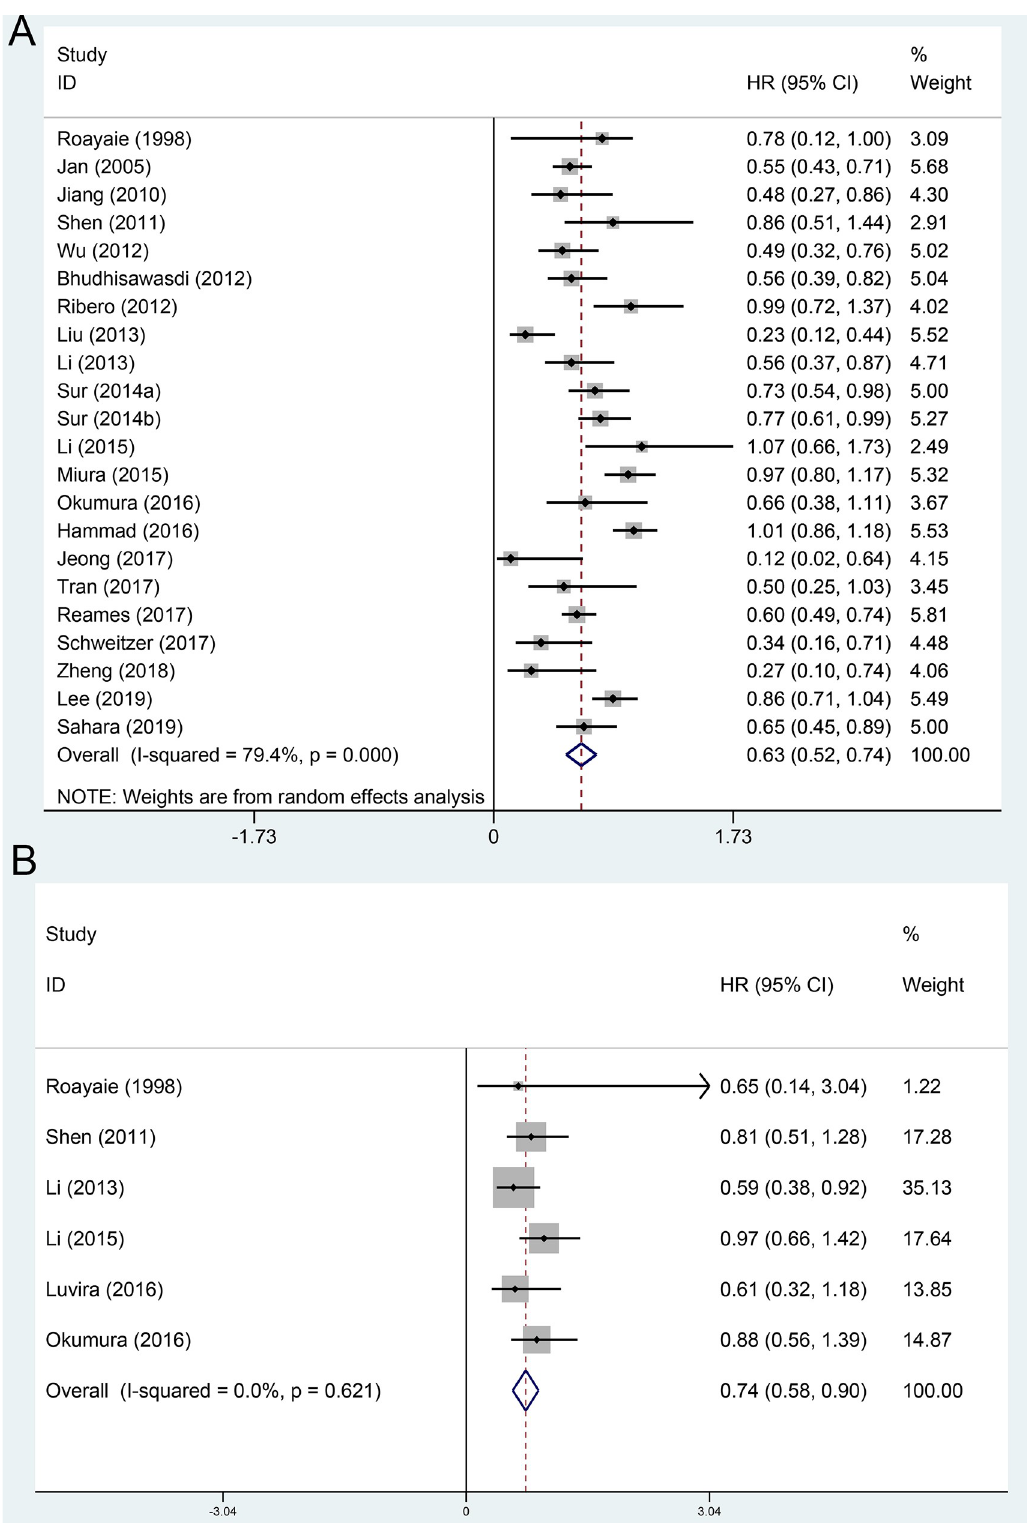
Fig 2. Forest plot of the overall survival and recurrence-free survival rates between adjuvant therapy and operation only. A, overall survival; B, recurrence-free survival.